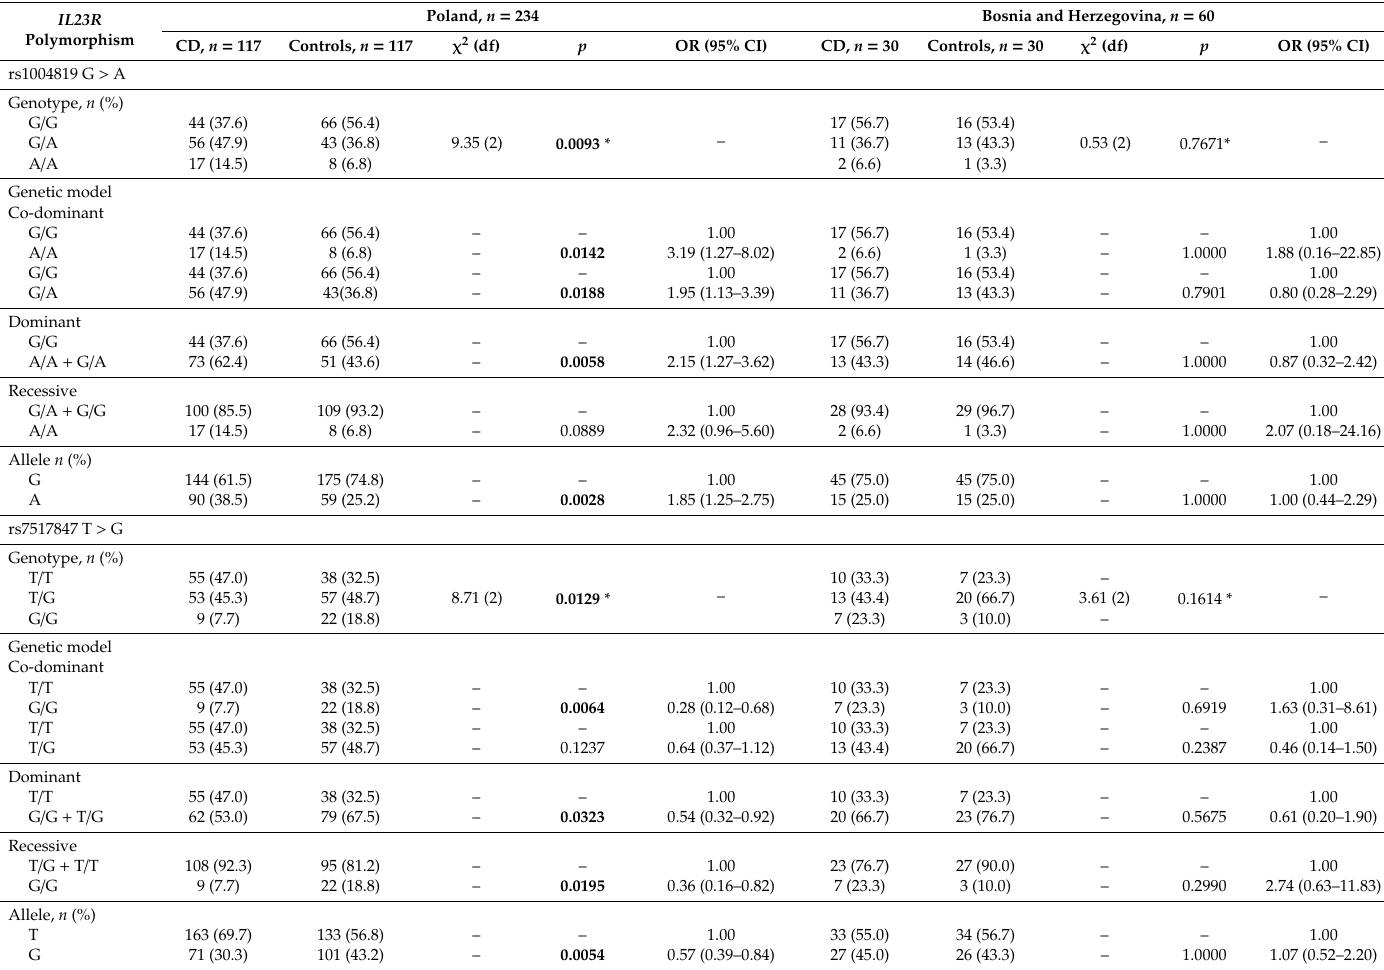
Table 2. Genotype and allele frequencies and case-control associations for IL23R